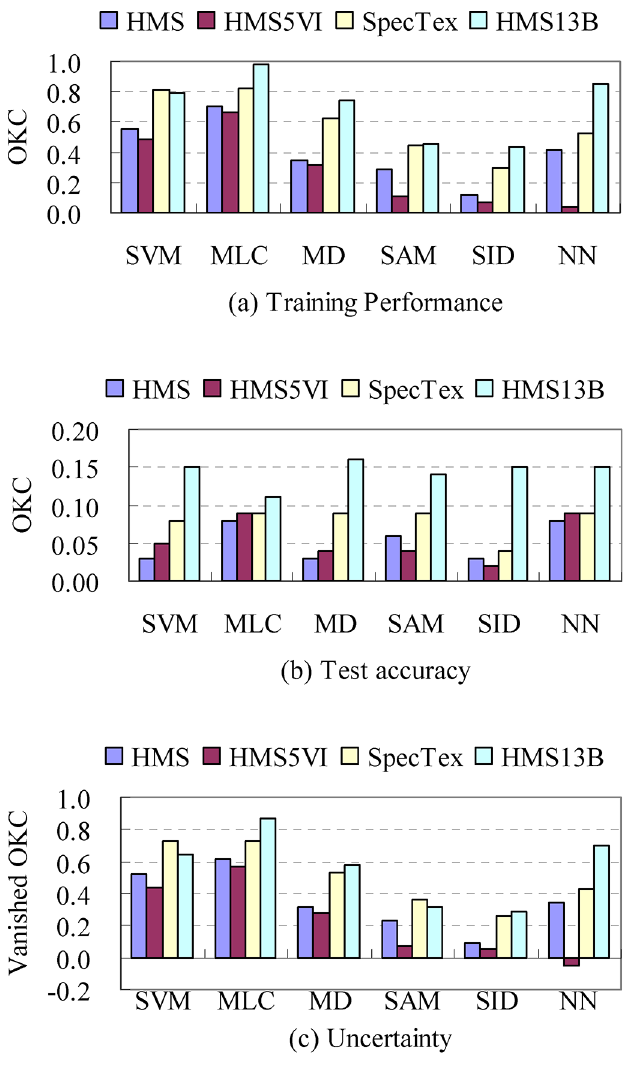
Fig 7. A comparison of the training performance, test accuracy, and uncertainty among classifiers in variant classification